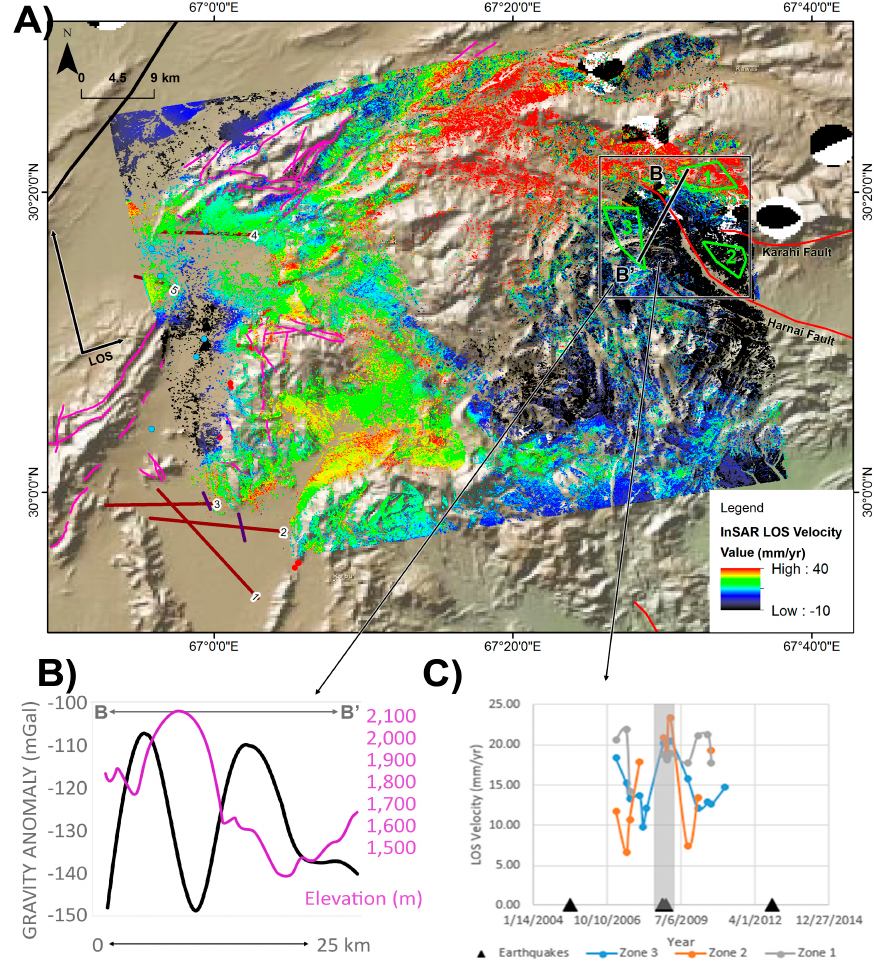
Figure 8. ( A ) SBAS results generated from 15 ascending PALSAR scenes from 2006 to 2011 show a surface deformation velocity ranging from − 10–40 mm/year. ( B ) The profile BB’ shows changes in gravity across the Karahi and Harnai Faults. The gravity data indicate the presence of three different fault blocks that cross faults. ( C ) The SBAS multi-temporal analysis shows a change in pre-, co-, and post-seismic velocity rates for zones 1, 2 and 3 at the epicenters of the 2008 earthquake swarms.